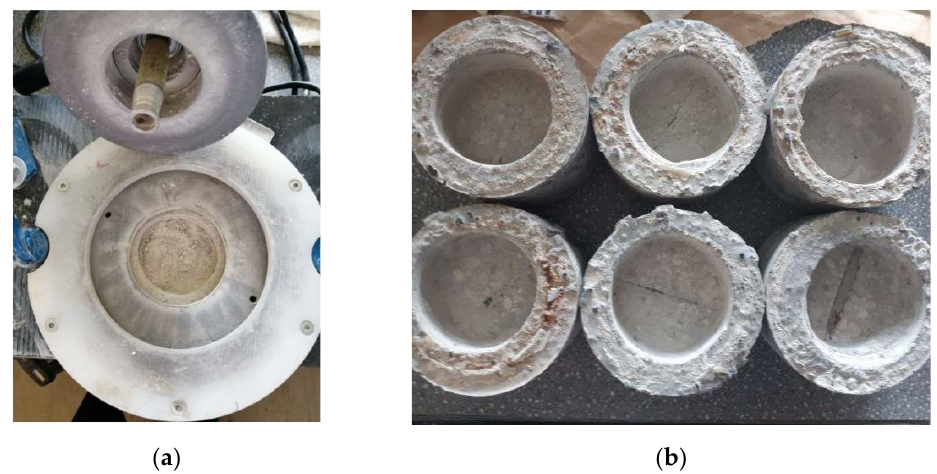
7 of 18 Figure 6. Distribution: ( a ) of corrosion current densities and ( b ) corrosion potential obtained selected specimen C1.1, C1.2, C2.1 and C2.2: M0 — before chloride migration), M1 — after 7 days, M2 — after 14 days of migration, E0 — after 21 days of migration, E1 — after 10 days of chloride extraction and E2 — after 21 days of extraction. 3.2. Material Tests — Determination of Distribution of Chloride and Hydroxide Ion Concentration at the Depth of Concrete Cover When initiation of corrosion processes was found on the basis of interpretation of polarization measures with the LPR method, electrodiffusion was not continued and chloride profile at the depth of reinforcement cover was determined. For that purpose,